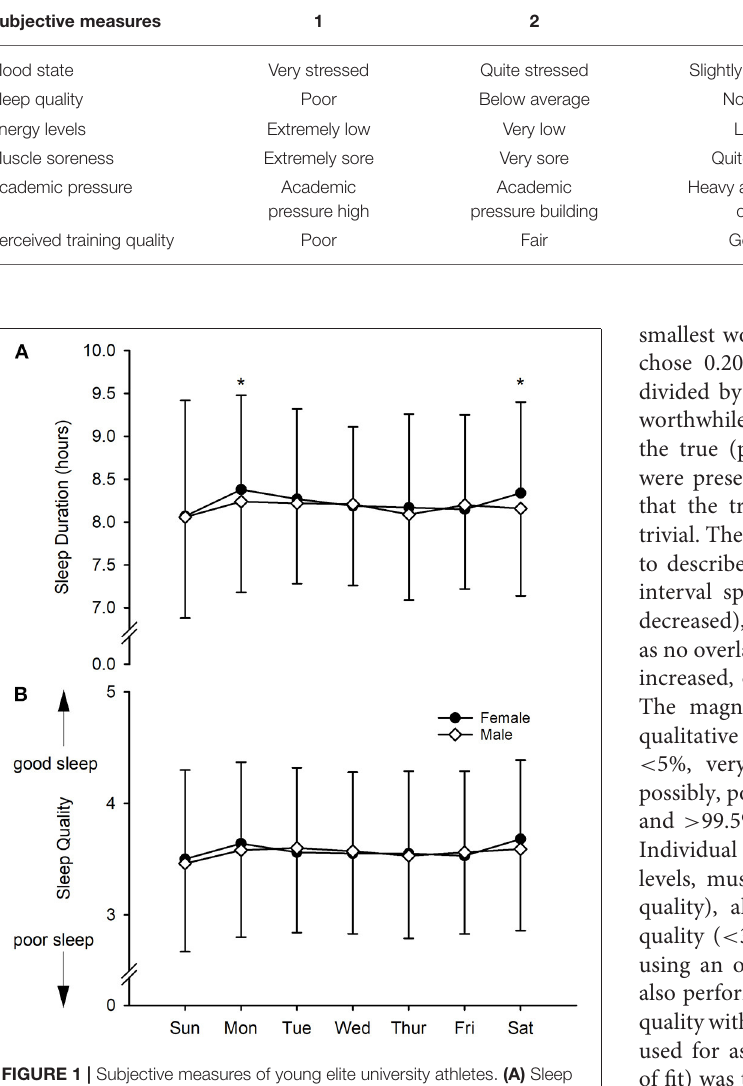
FIGURE 1 | Subjective measures of young elite university athletes. (A) Sleep duration, (B) sleep quality. Values are daily means with SD as error bars. *Substantially different between male and